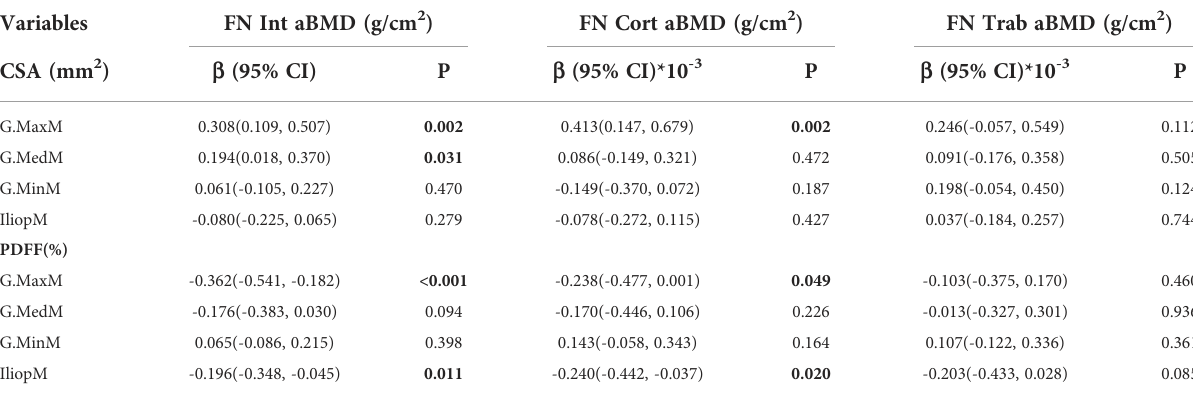
TABLE 2 Generalized multiple linear standardized regression coef fi cients and 95% CIs between the aBMD of the FN and various muscle indexes a, b,c in males.